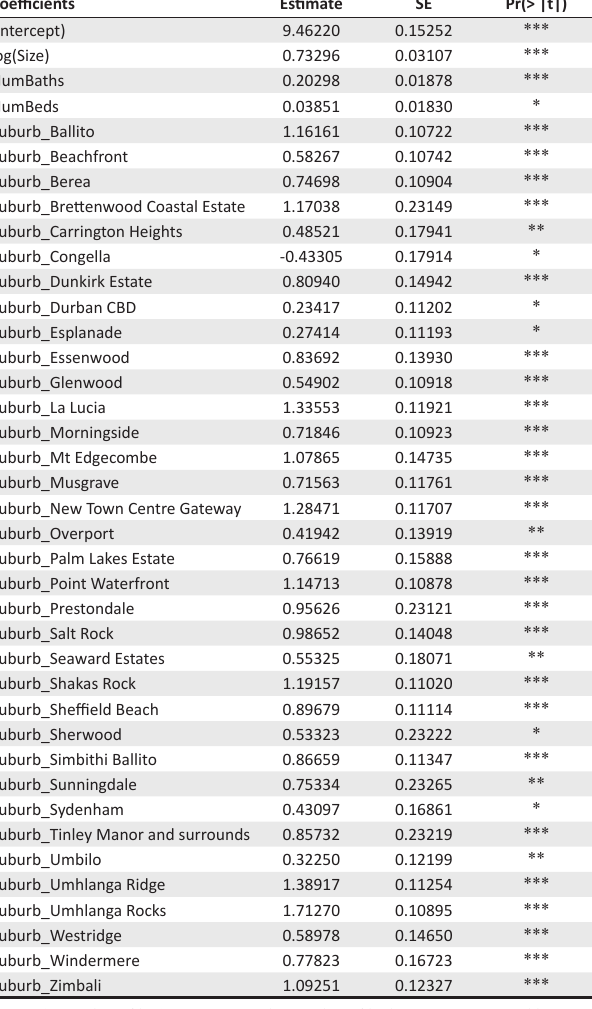
TABLE 4: Generalised linear model output.